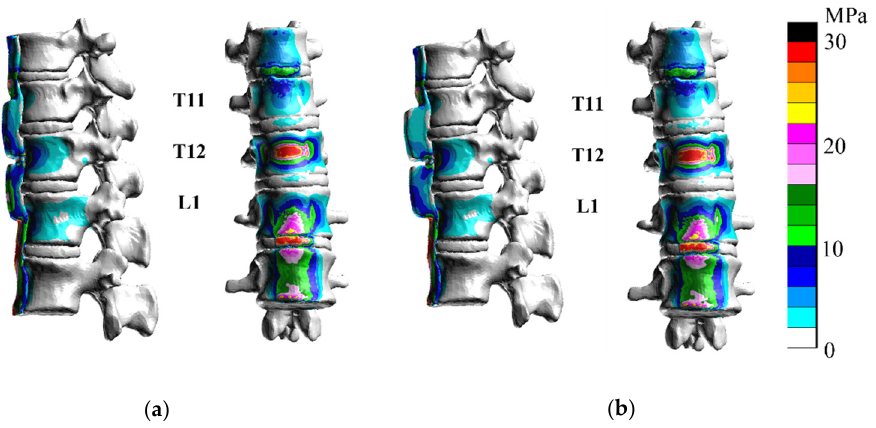
Figure 8. In D-5/R-2.5 ( a ) and D-10/R-2.5 ( b ), the stress at the center of T12 increased at the discontinuity in extension.